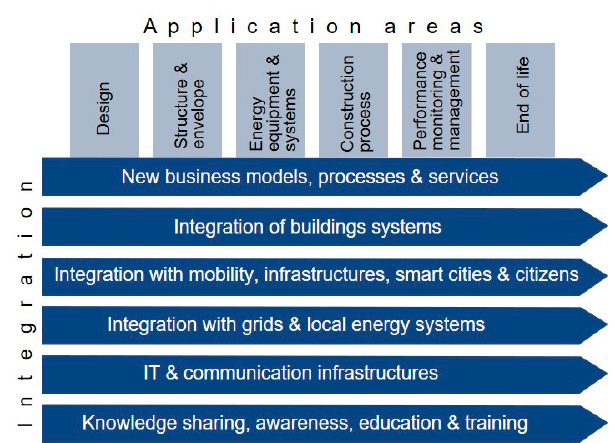
Figure 1. Summary of the enabling role of information communication technologies (ICT) [23].